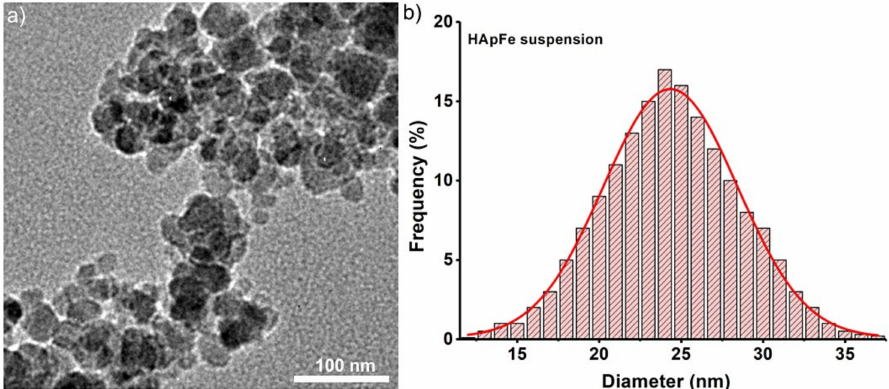
Figure 4. The TEM image of iron-doped hydroxyapatite ( a ) and the particle size distribution ( b